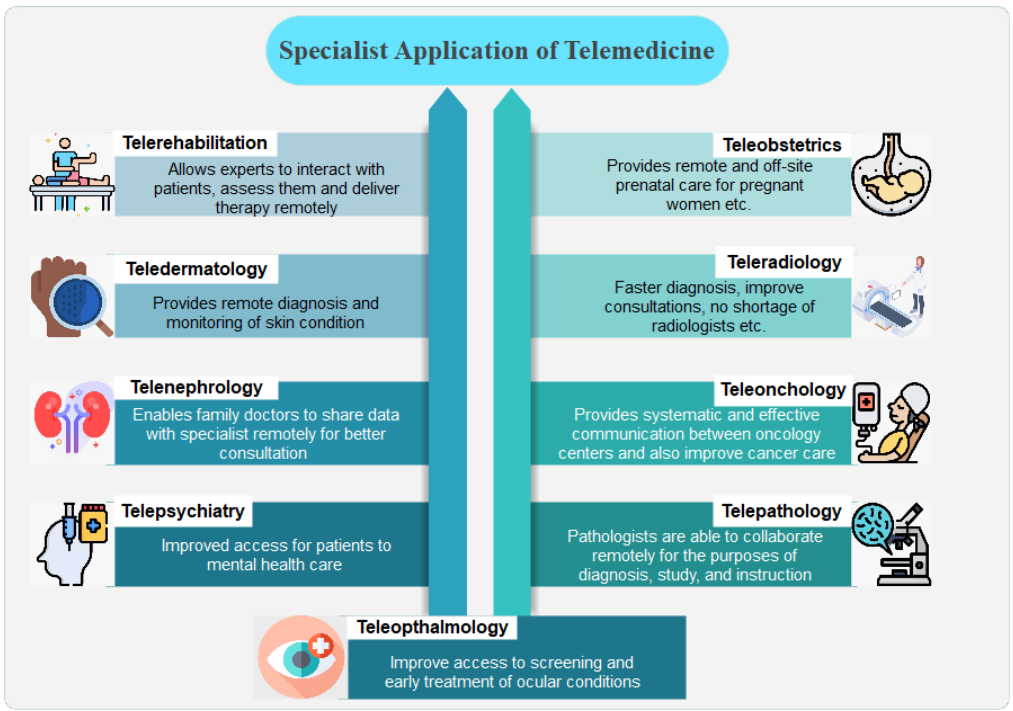
Figure 4. Applications of